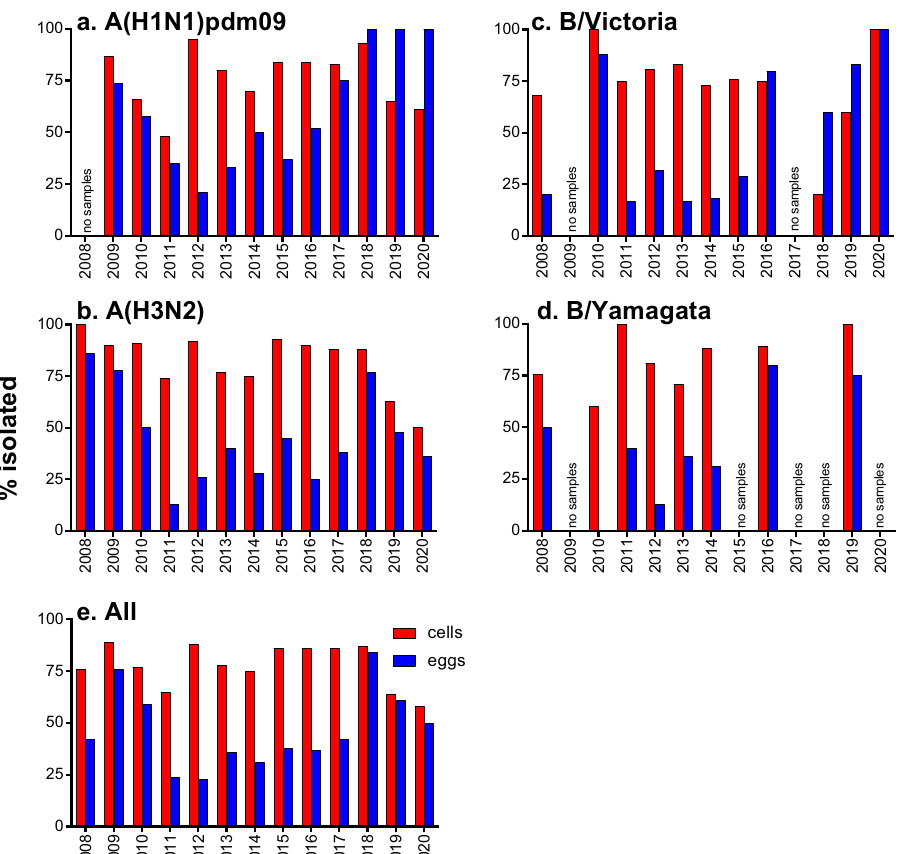
Fig. 2 Isolation rates of all human in fl uenza viruses tested in cells and eggs. Proportion recovered in cells (red bar) or eggs (blue bar) by year of sample collection is shown for A(H1N1)pdm09 ( a ), A(H3N2) ( b ), B/Victoria ( c ), B/Yamagata ( d ) and all ( e ) viruses.